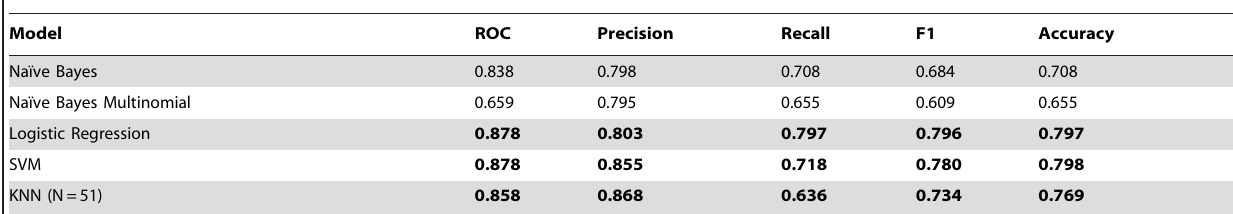
Table 3. 10-fold cross-validation on the training set.